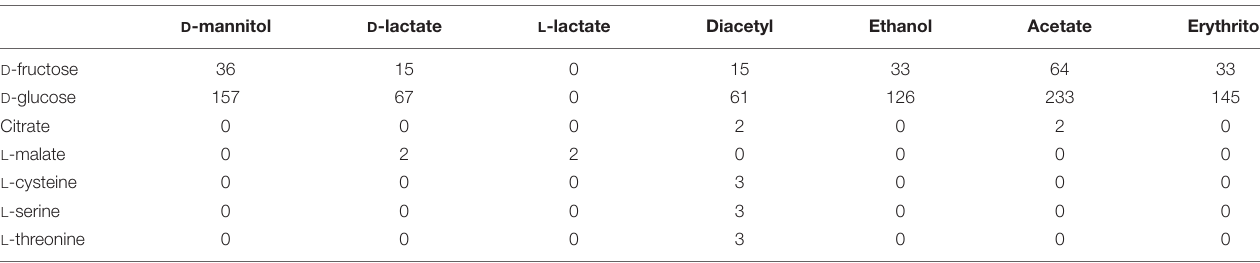
TABLE 3 | Determination of possible substrate-product relationships by EFMA. D -mannitol D